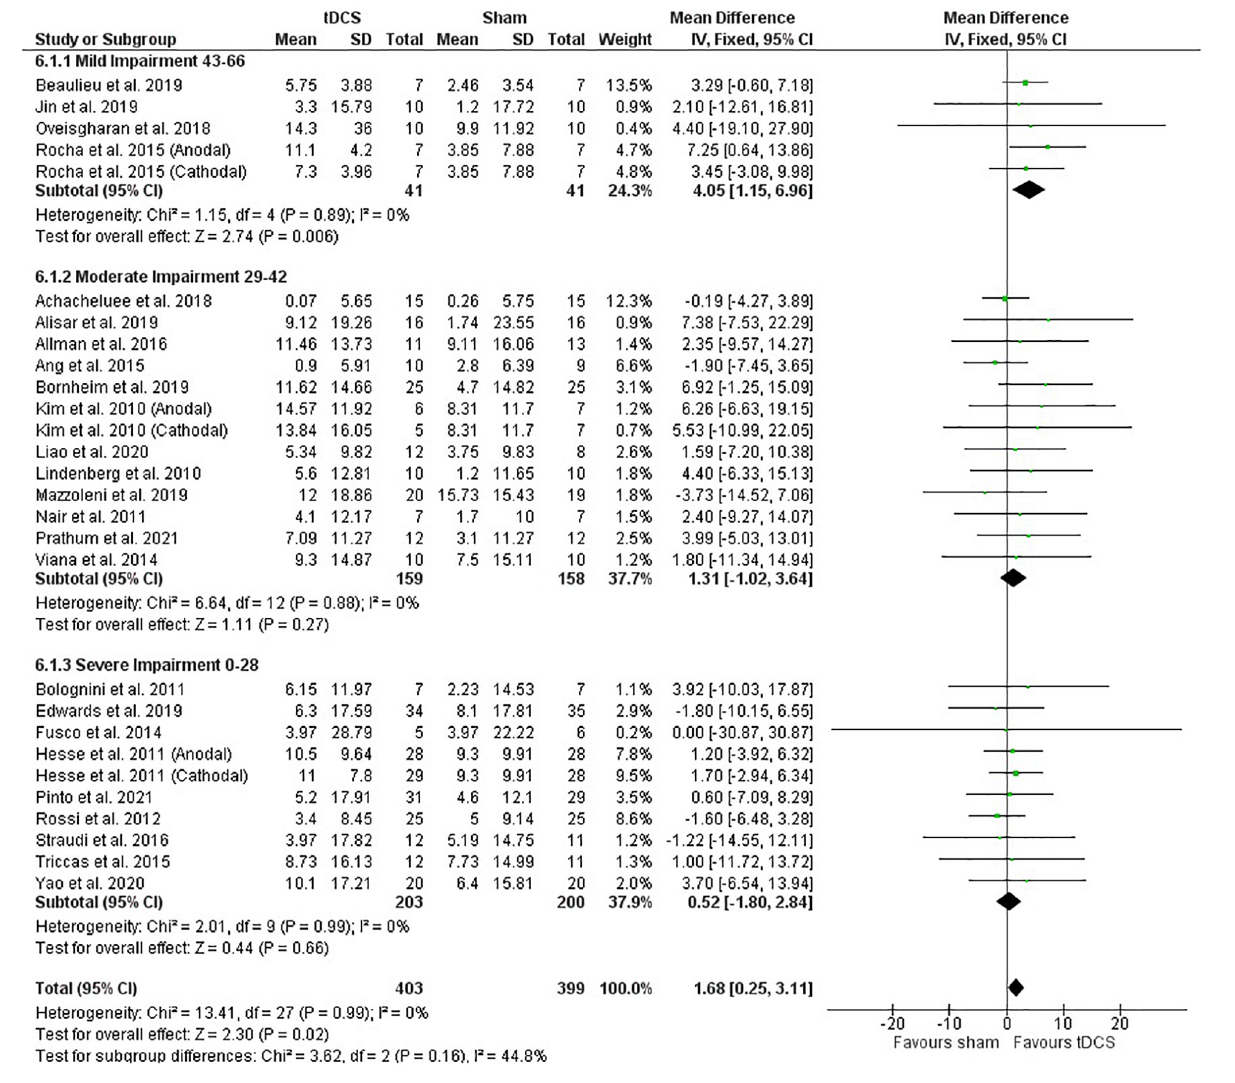
FIGURE 3 | Effects of tDCS on stroke recovery as assessed by the change scores (mean difference between baseline and post-intervention) of the tDCS and sham groups for the upper extremity Fugl–Meyer